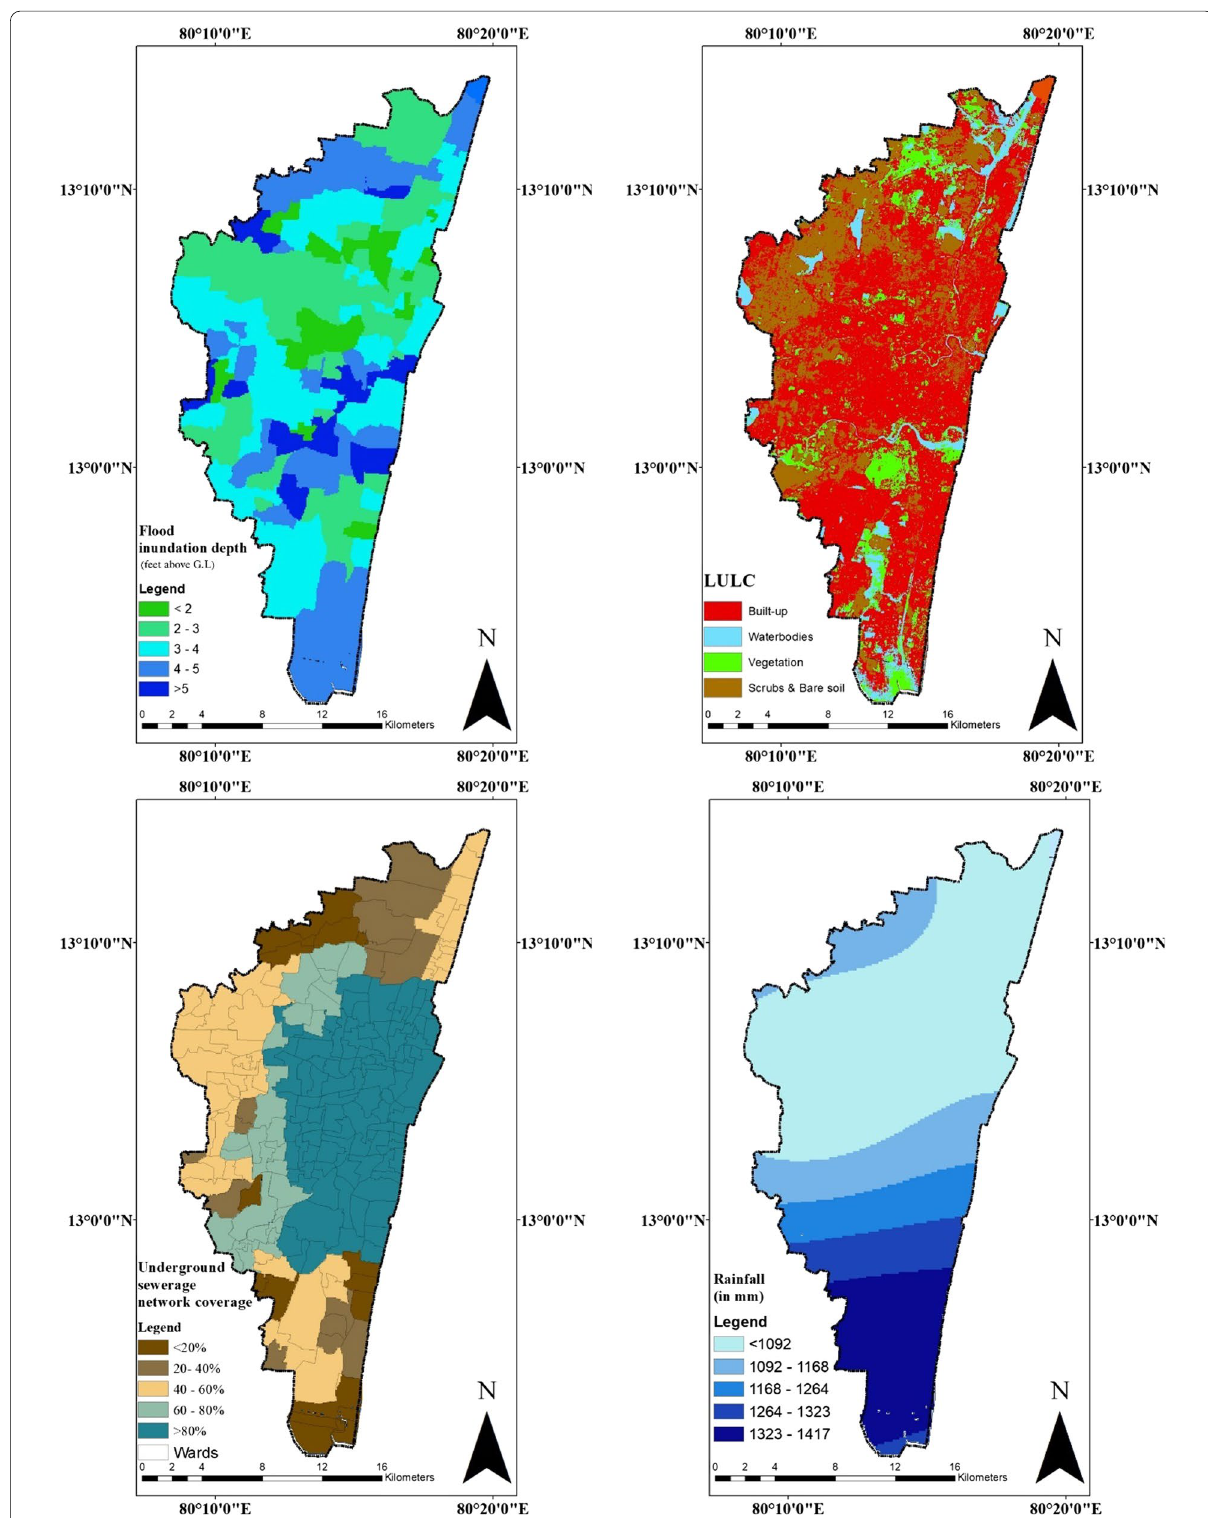
Fig. 4 Flood inundation, LULC, underground sewerage network coverage and rainfall